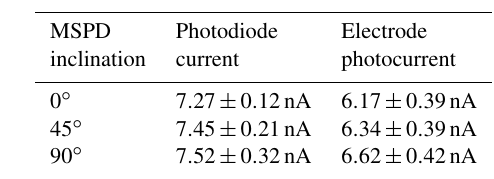
Table 1. Average electrode photocurrent and photodiode current for each